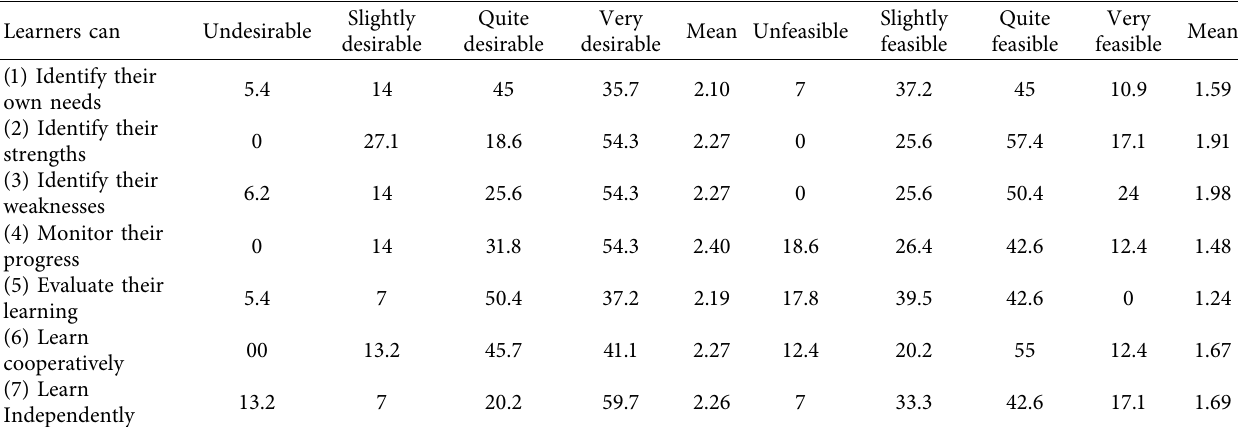
Table 10: Descriptive statistics of the desirability and feasibility of learning to learn skills in